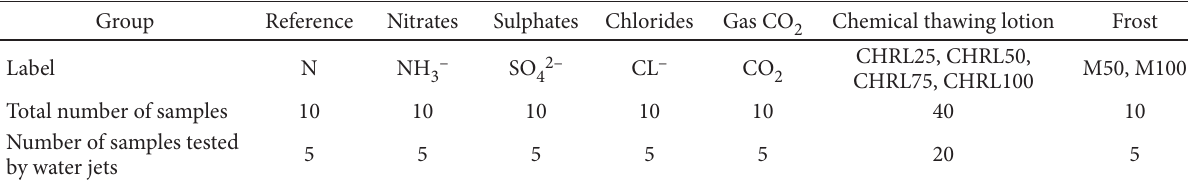
Table 2. Concrete samples – division into tested groups and their labelling Group